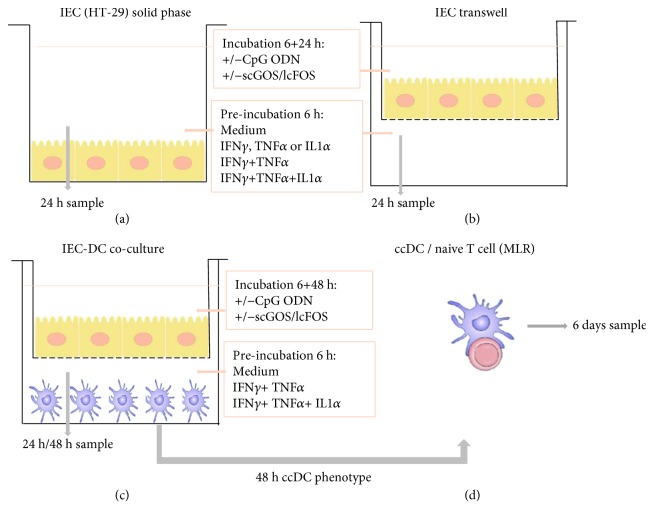
Methods for in vitro studies. HT29 cells (IEC) cultured on solid phase plates were preincubated with IFNγ, TNFα, and IL1α (all 10 ng/mL) alone or in combinations for 6 h, washed, and exposed to medium for 24 h (a). IEC cultured on transwell filters (b, c) were basolaterally preincubated with IFNγ and TNFα in the presence or absence of IL1α (all 10 ng/mL) and apically exposed to scGOS/lcFOS±synthetic CpG-ODN for 6 h, washed, and basolaterally exposed to either medium for 24 h (b) or immature DC for 48 h (c), while apically reexposed to medium, scGOS/lcFOS±synthetic CpG-ODN. After 48 h of IEC-DC coculture, ccDC were added to allogeneic naïve T cells for 6 days (MLR) (d) and immune mediators were measured. scGOS/lcFOS: short-chain galacto- and long-chain fructo-oligosaccharides; CpG-ODN: synthetic CpG-ODN type C (TLR9 ligand); imDC: immature DC; ccDC: coculture DC; MLR: mixed lymphocyte reaction.